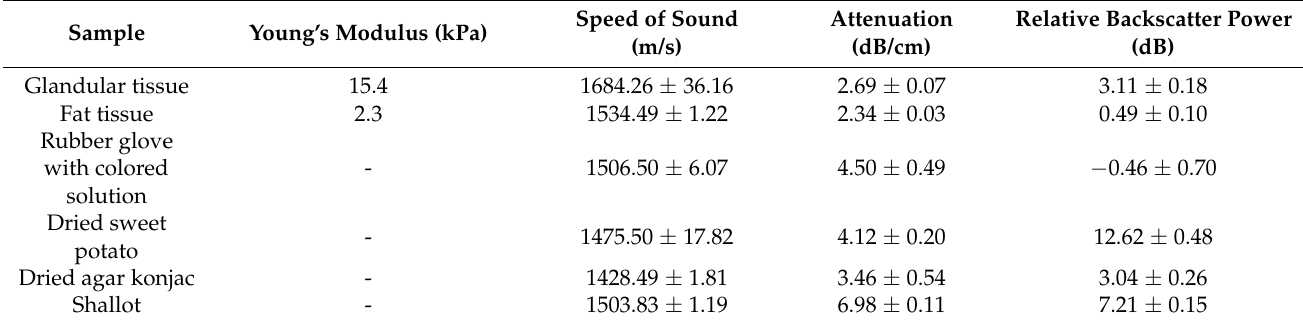
Table 3. Experimental results of mechanical and acoustic properties for simulated glandular tissue, fat tissue and tumor.